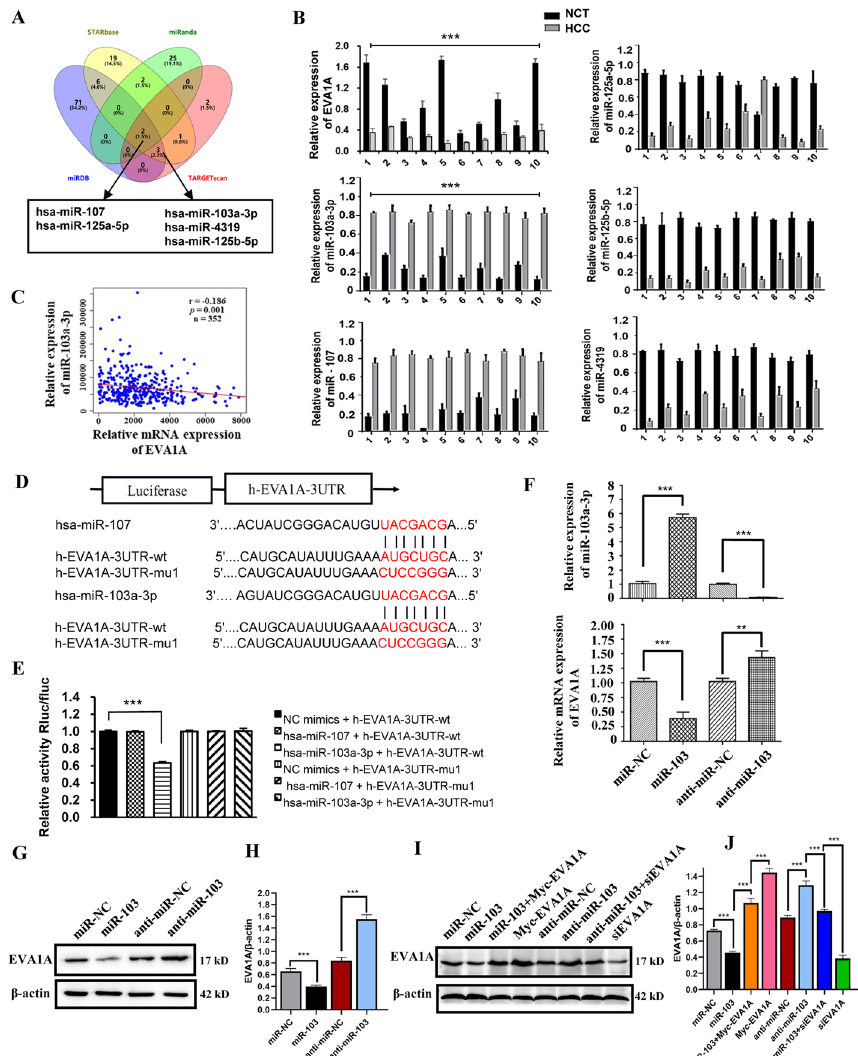
Fig. 2 EVA1A is a direct target gene of miR-103a-3p. A The potential upstream microRNA of EVA1A by microRNA prediction databases. B Ten pairs of samples were randomly selected, RT-qPCR analysis of EVA1A mRNA levels and predicted five microRNA levels. C miR-103a-3p expression was inversely correlated with EVA1A levels according to data from HCC patients in the TCGA cohort ( p 0.001; Pearson correlation). D = Scheme of the potential binding sequence of miR-103a-3p and miR-107 within the human EVA1A 3 ′ UTR and construction wild-type (wt) and mutated (mut) luciferase plasmids basing on the EVA1A 3 ′ UTR binding sequence. E Human miR-103a-3p or mimic controls (NC mimics) were co-transfected wt or mut EVA1A-3 ′ UTR in 293 T cells and luciferase assay was conducted. F Hccl-M3 cells were transfected with synthetic mimics of miR-103a-3p (miR-103) or its control miR-NC, inhibitors of miR-103a-3p (anti-miR-103) or its control anti-miR-NC, then the relative expression of miR-103a-3p and EVA1A was determined by RT-qPCR. G , H Hccl-M3 cells were treated as indicated, and the EVA1A protein level was determined by western blot. I Hccl-M3 cells were co-transfected with miR-103a-3p mimics and Myc-EVA1A plasmid, or were co-transfected with miR-103a-3p inhibitors and siRNA of EVA1A (siEVA1A), or transfected with Myc-EVA1A plasmid or siEVA1A. Then the EVA1A protein level was determined by western blot. J Quantitative analysis of the blot bands of EVA1A with ImageJ v1.53 k. Data are shown as means SD from three independent experiments. ± ** P < 0.01, *** P <